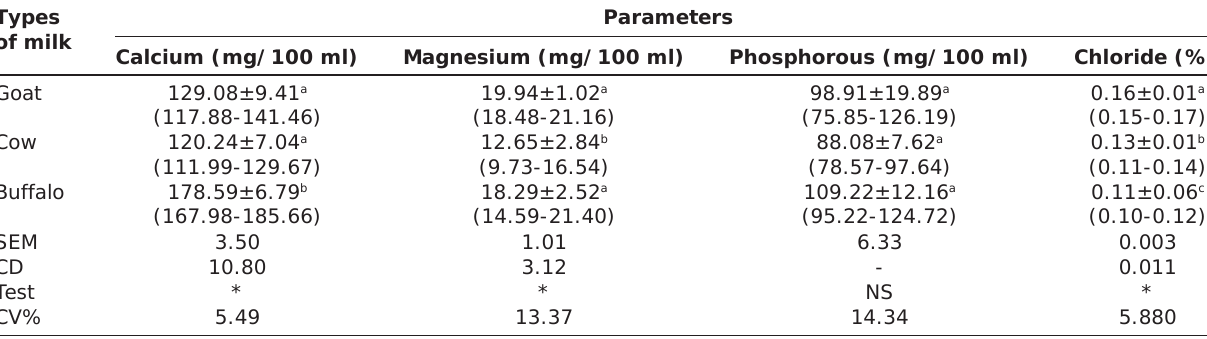
Table-3: Selected mineral content of goat, cow, and buffalo milk. Types of